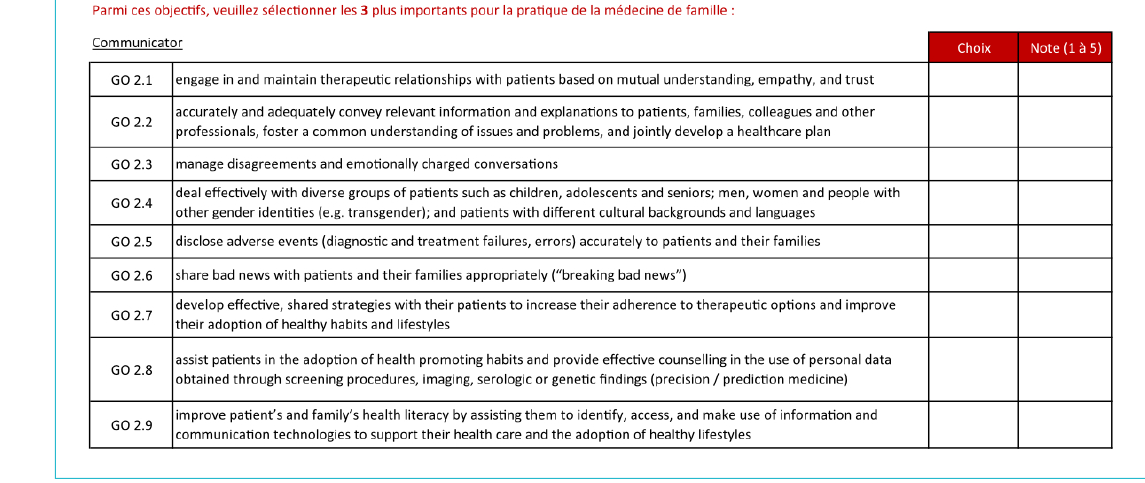
Figure 4: Example of a round 2 question. For the “communicator” subgroup of PROFILES, the experts were asked to choose the three objec- tives that they felt were most important for the practice of family medicine from the nine objectives identified in the first round. They were asked to rate each of these three objectives from 1 to 5, 1 being “important” and 5 being “most